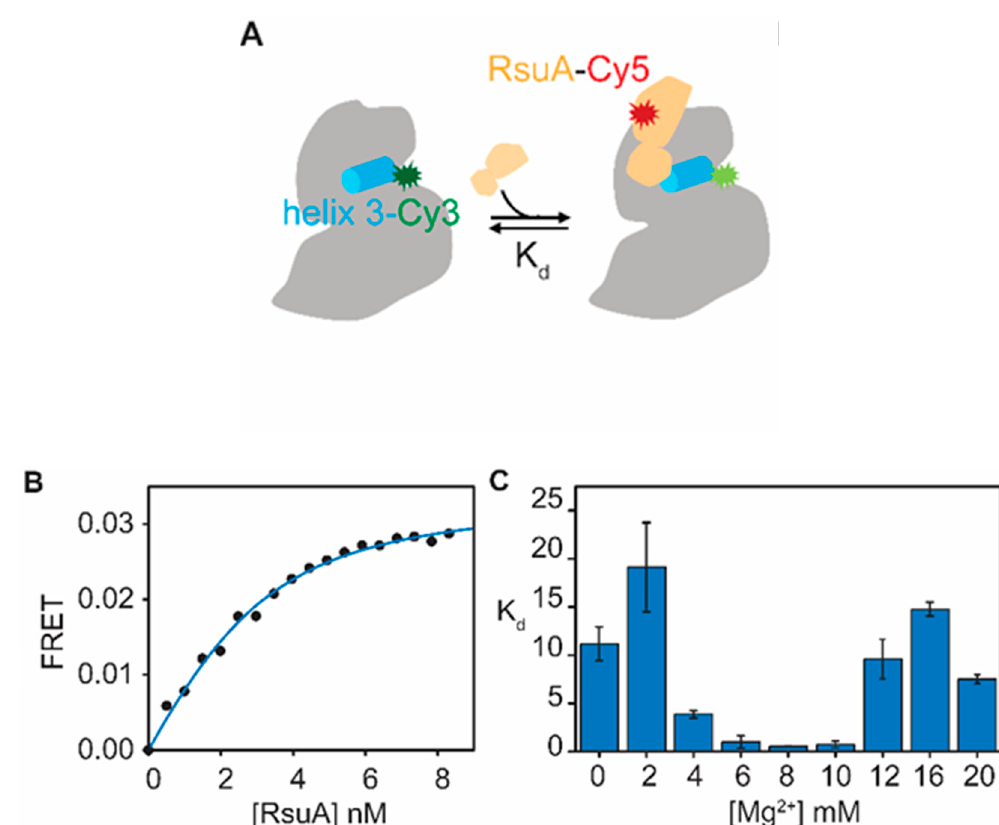
Figure 2. Protein ribosomal small subunit pseudouridine synthase A (RsuA) binds to the 30S 5 ′ -domain. ( A ) Florescence labeling scheme used for FRET-based RsuA binding assays is shown. Helix 3 (cyan) of the 30S 5 ′ -domain (gray) is annealed with a DNA primer conjugated to Cy3 dye (green), whereas protein RsuA (wheat) is labeled with Cy5 dye (red) at Cys127. ( B ) A representative RsuA titration curve at 4 mM [Mg 2+ ]. ( C ) Binding affinities of protein RsuA to the 5 ′ -domain of 16S rRNA in various Mg 2+ concentrations (0–20 mM) are shown. RsuA titrations were performed in HKM X buffer (80 mM K-Hepes pH 7.6, 330 mM KCl, and 0–20 mM MgCl 2 ). Error bars represent errors obtained by